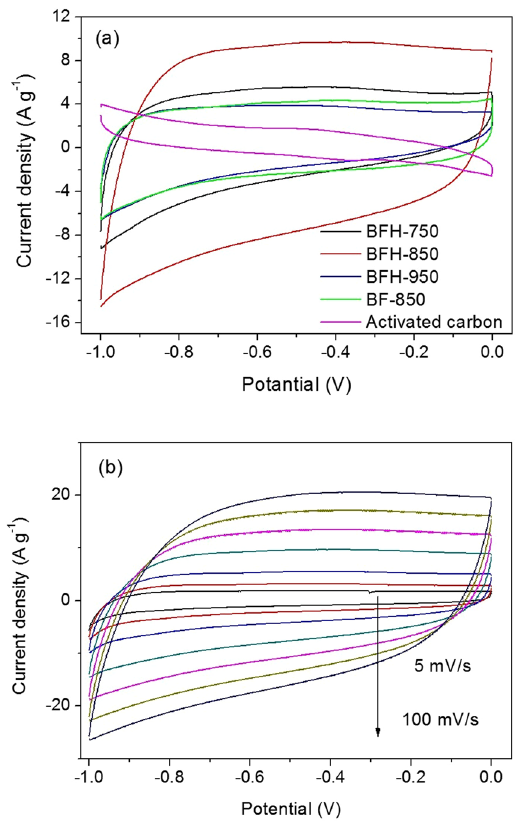
Figure 6. ( a ) CV curves of BF-850, BFH-750, BFH-850, and BFH-950 at a scan rate of 50 mV s − 1 , ( b ) CV curves of BFH-850 at various scan